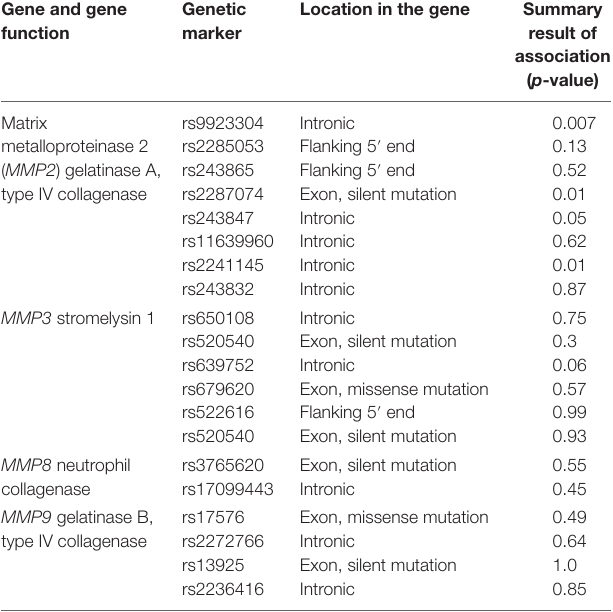
gene and gene function